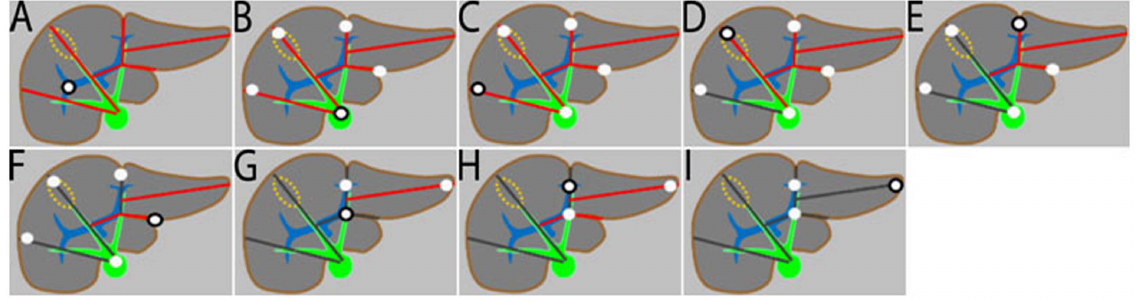
Figure 1. Semi-automated Interactive Software for CT-volumetry (P) – Manual Positioning of 9 Anatomical Landmarks to Define the Segments of Couinaud (Schematic Illustration; Courtesy of Philips Healthcare Germany, Hamburg, Germany). A first bifurcation of the right portal vein (black circle). B inferior caval vein (black circle). C right hepatic vein (black circle). D middle hepatic vein (black circle). E left hepatic vein (black circle). F superficial ligamentum venosum (black circle). G deep ligamentum venosum (black circle). H end of left portal vein (black circle). I left liver tip (black circle) Note: after automated outline of the entire liver with correction of false-positive and false-negative extractions, and then after manual positioning of the 9 anatomical landmarks, volumes of transplanted liver segments are